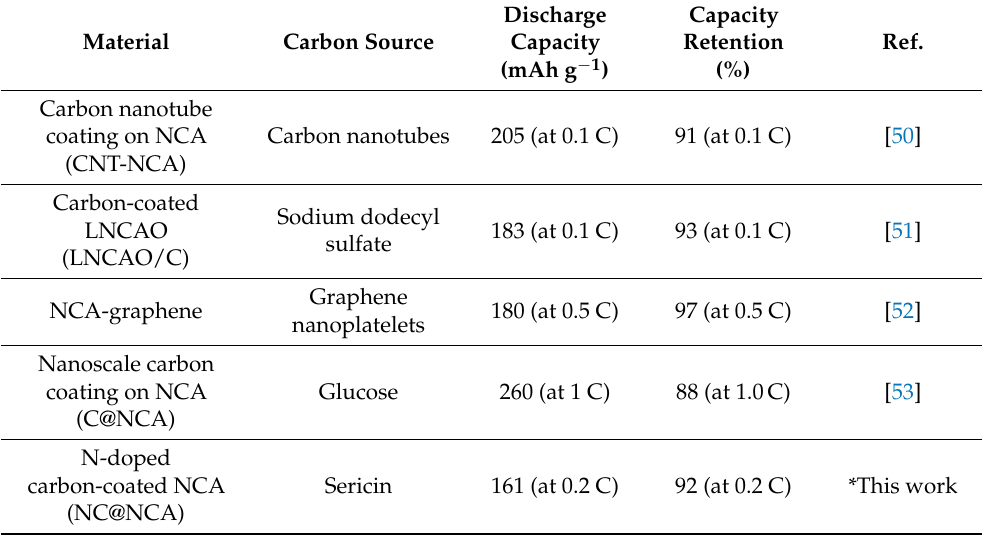
Table 3. Comparison of previously reported similar studies with current